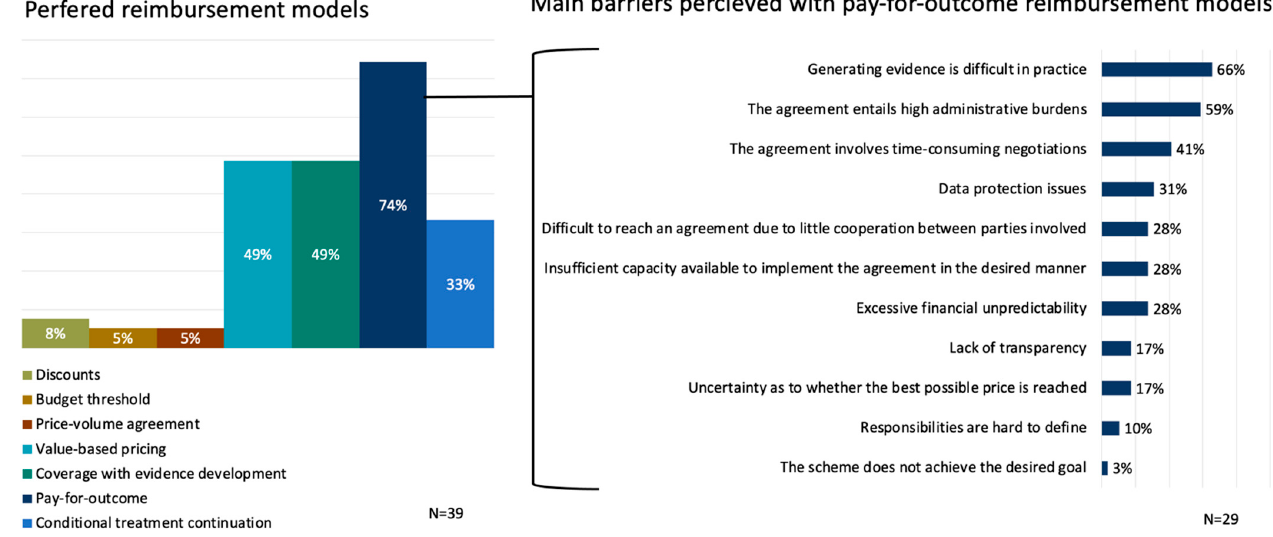
Figure 2. Preferred reimbursement models ( left ) and the main perceived barriers with pay-for-outcome models as the most preferred model ( right ).